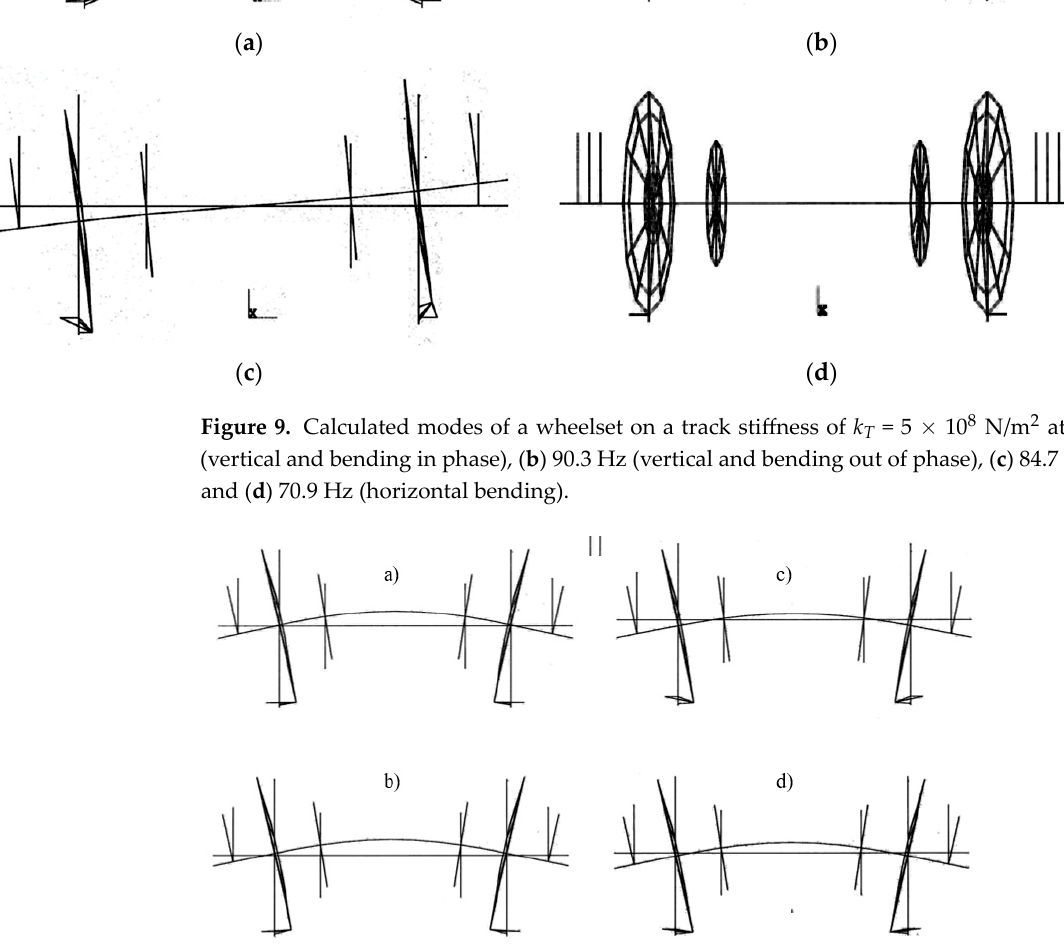
Figure 9. Calculated modes of a wheelset on a track stiffness of k T = 5 × 10 8 N/m 2 at ( a ) 62.7 Hz (vertical and bending in phase), ( b ) 90.3 Hz (vertical and bending out of phase), ( c ) 84.7 Hz (rolling), and ( d ) 70.9 Hz (horizontal bending).